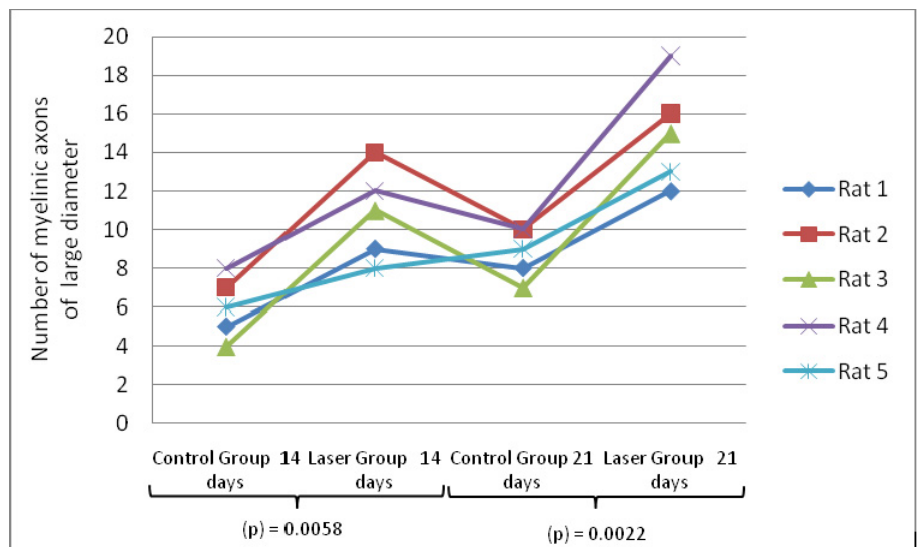
FIGURE 6 – Presence of myelinic axons of large diameter in the histological findings at groups in 14 and 21 days. Source: Fieldwork archive,